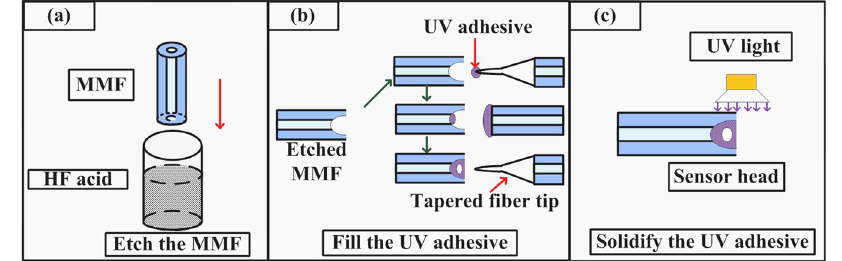
Figure 1. Schematic diagram of the fabrication process of the optical fiber sensor head. ( a ) A taper-shaped hole at the end of MMF is formed by HF etching. ( b ) The taper-shaped hole at the end of MMF is filled with UV adhesive to form an inner air-cavity. ( c ) The UV adhesive is solidified.